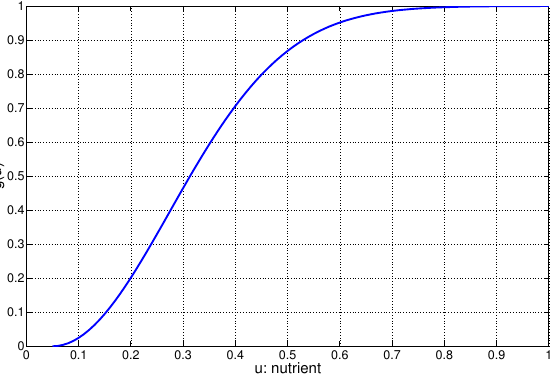
Figure 4. Illustration of the nutrient-dependent model for nutrient loss g ( u ) (3) as a function of non-dimensional nutrient concentration in the cell model. The case with λ = 10 /u 2 minimum nutrient concentration u ∗ /u concentration used in the